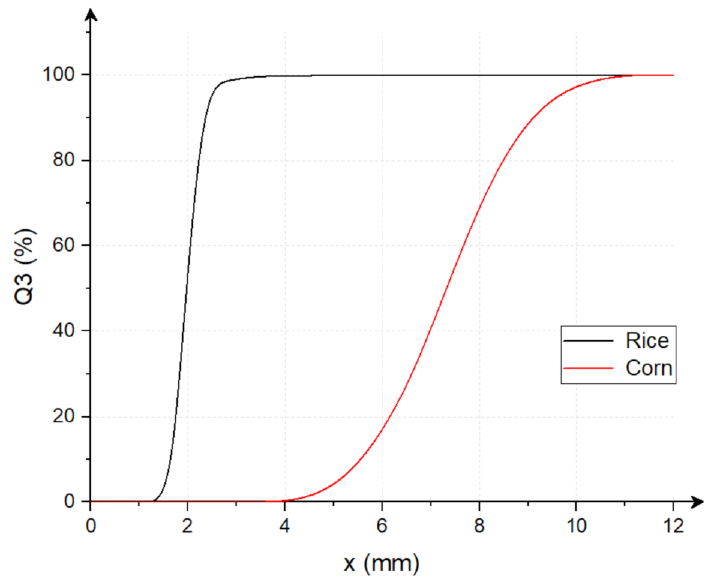
Figure 3. The cumulative particle size distribution of rice and corn grains before comminution; Q3—cumulative size distribution (based on volume), x—particle diameter, which is the shortest chord of the measured set of maximum chords of a particle